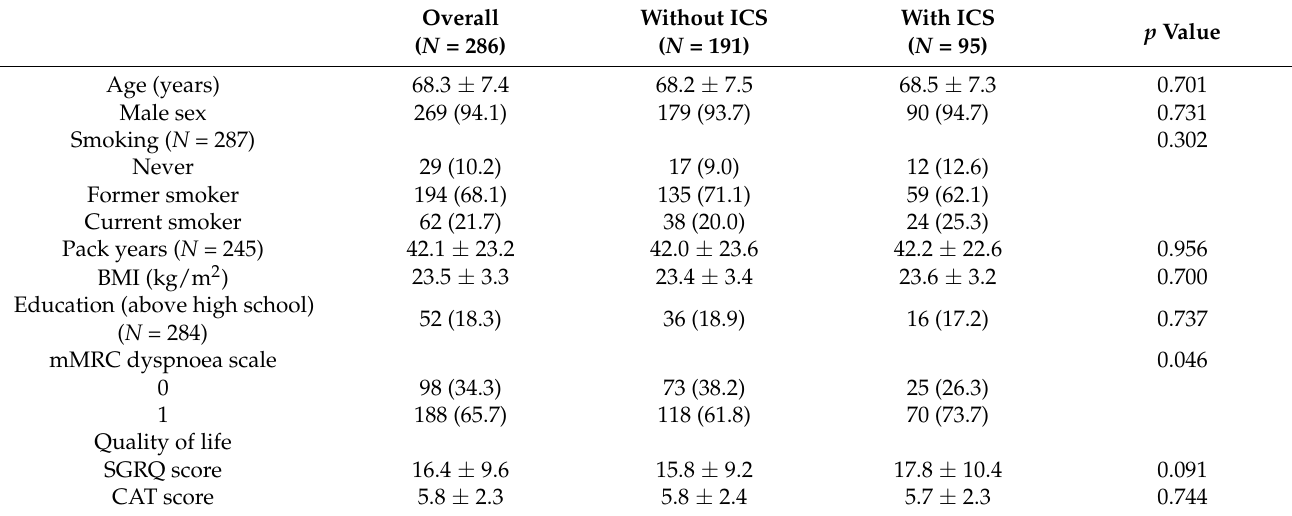
Table 1. Baseline characteristics of